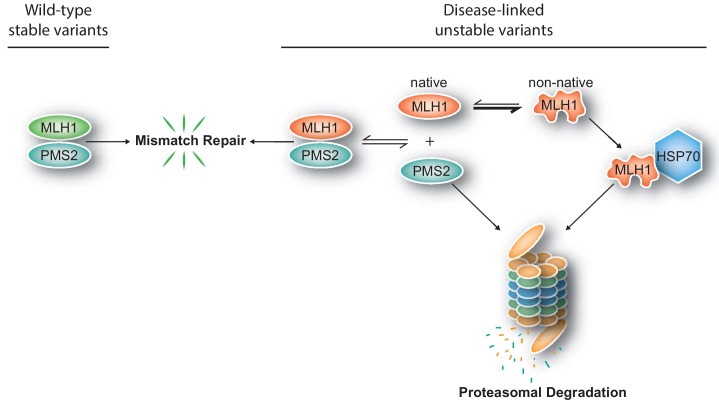
Model for how structural destabilization of MLH1 contributes to disease.The wild-type (green) MLH1-PMS2 heterodimer promotes DNA mismatch repair. Disease-linked missense MLH1 variants (red) may also promote DNA repair, but are at risk of dissociating from PMS2 due to structural destabilization. The structural destabilization of MLH1 may also cause a partial unfolding of MLH1 which is recognized by the molecular chaperone HSP70 and causes proteasomal degradation of the MLH1 variant. In turn, the degradation of MLH1 leaves PMS2 without a partner protein, resulting in proteasomal degradation of PMS2.